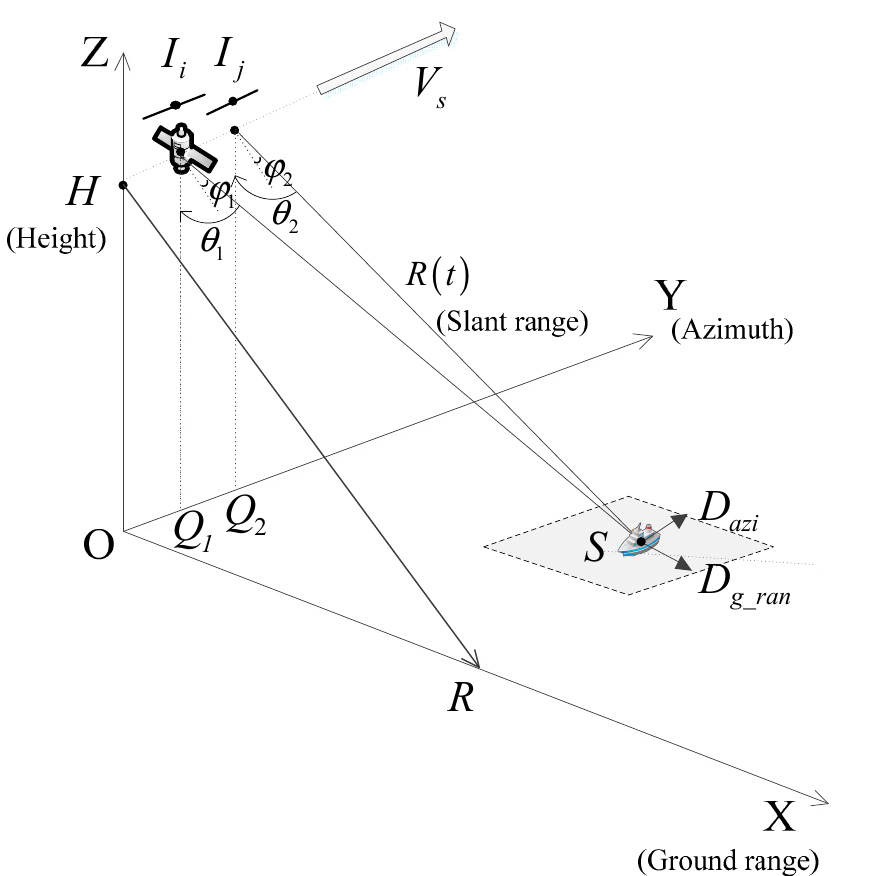
Figure 1. Acquisition geometry of low-resolution SAR images. (In the O-XYZ Cartesian coordinate system, the positions of the satellite during two image acquisitions are represented by Q 1 , Q 2 , and H ( R , Y ) forms the two-dimensional range coordinate system, which places the subpixel target S in the image sequences.)